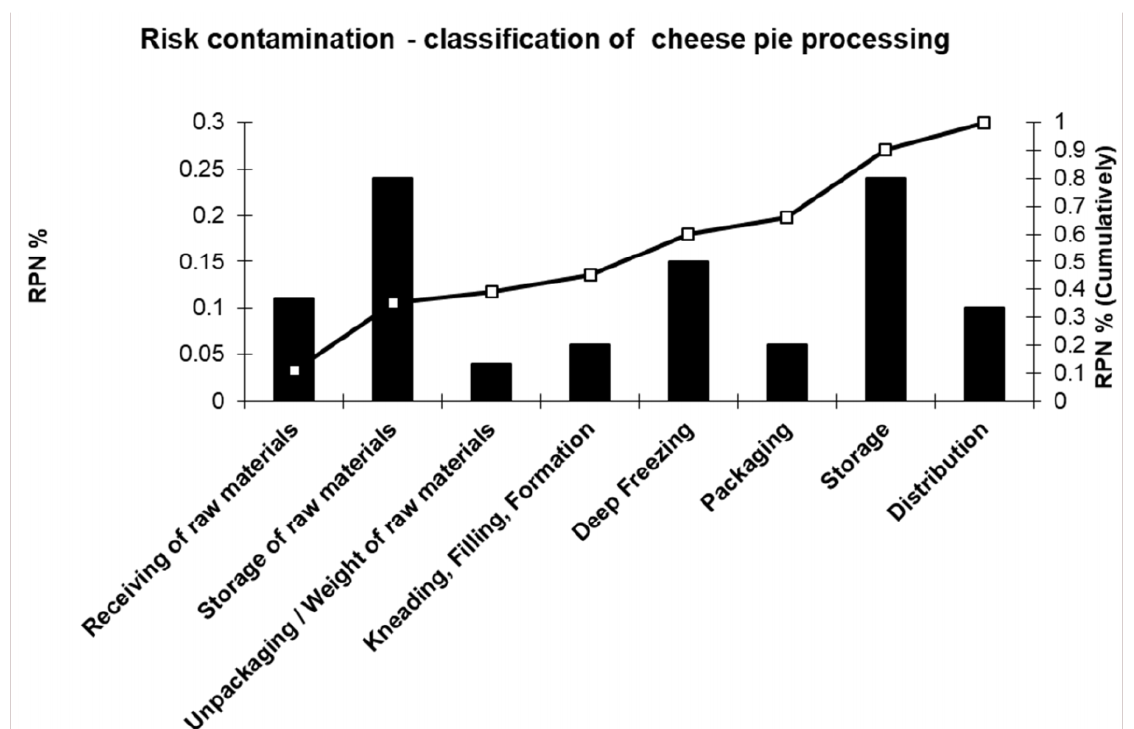
Figure 5. Pareto diagram of cheese pie processing prior to corrective actions.